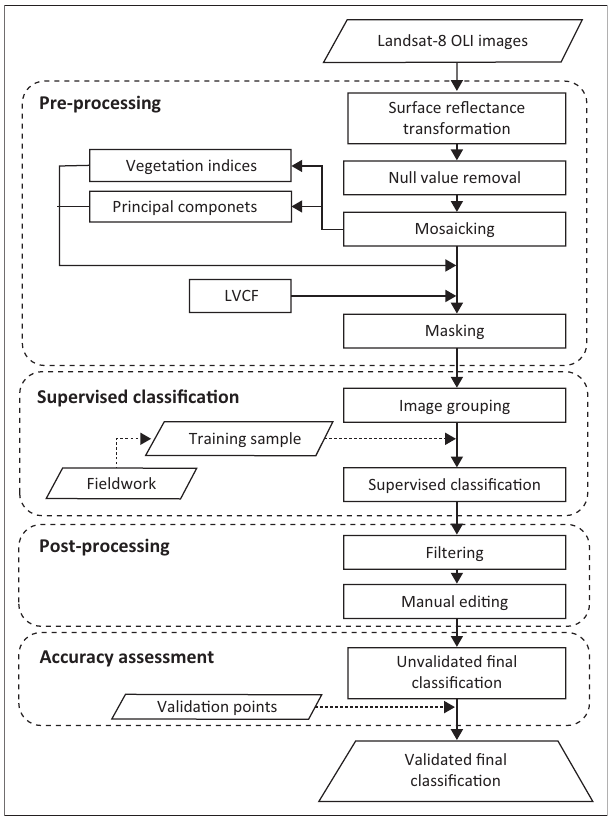
FIGURE 3: Overview of procedure for producing the vegetation structure